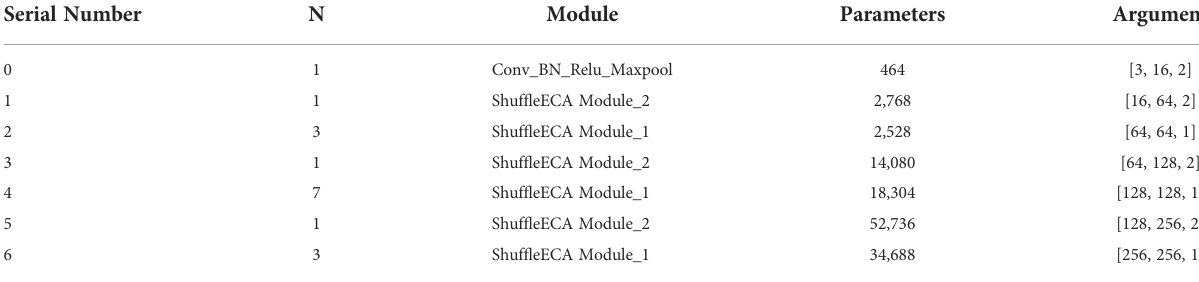
TABLE 1 Shuf fl eNetV2-ECA Backbone Network Structure Table. Serial Number